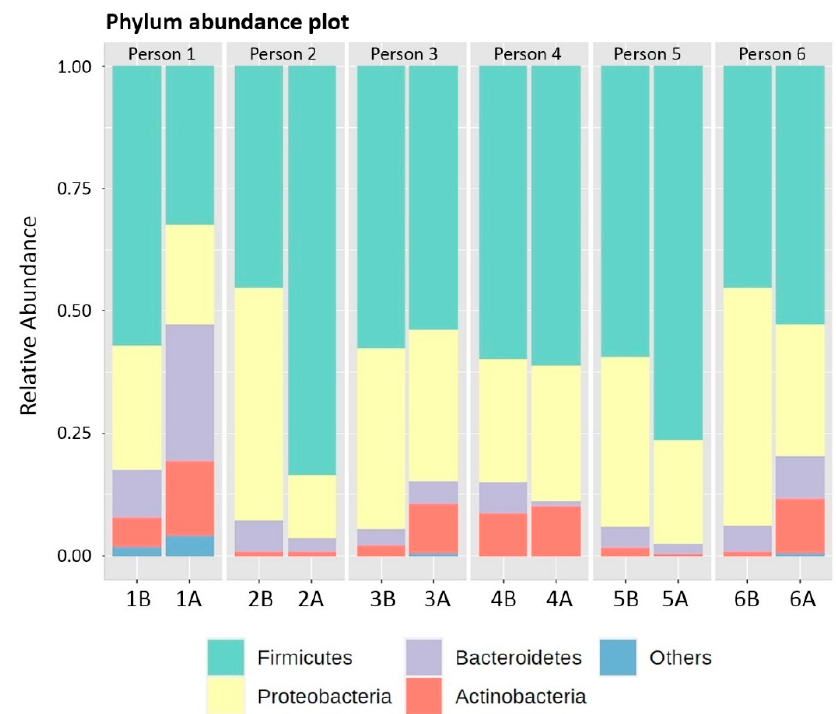
Polymers 2022 , 14 , x Figure 2. Relative abundance (%) of detected phyla. Figure 2. Relative abundance (%) of detected phyla.